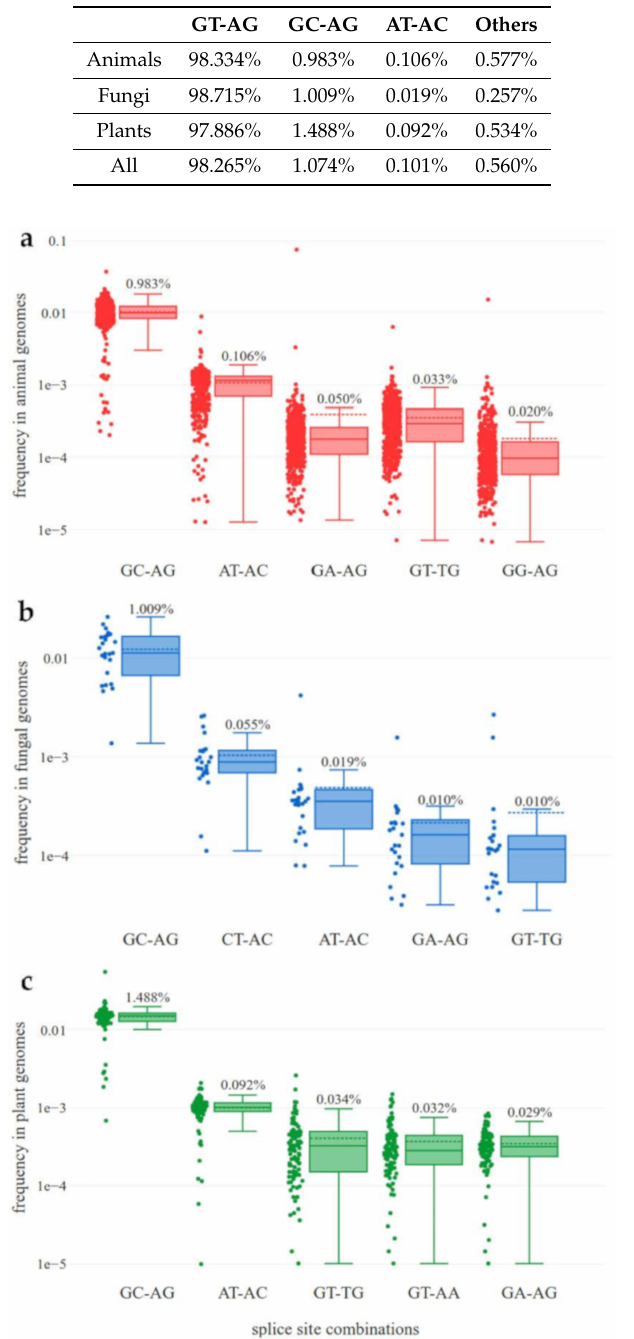
Table 1. Splice site combination frequencies in animals, fungi, and plants. Only the most frequent combinations are displayed here, and all minor non-canonical splice site combinations are summarized as one group (“Others”). A full list of all splice site combinations is available (Files S1 and S2).